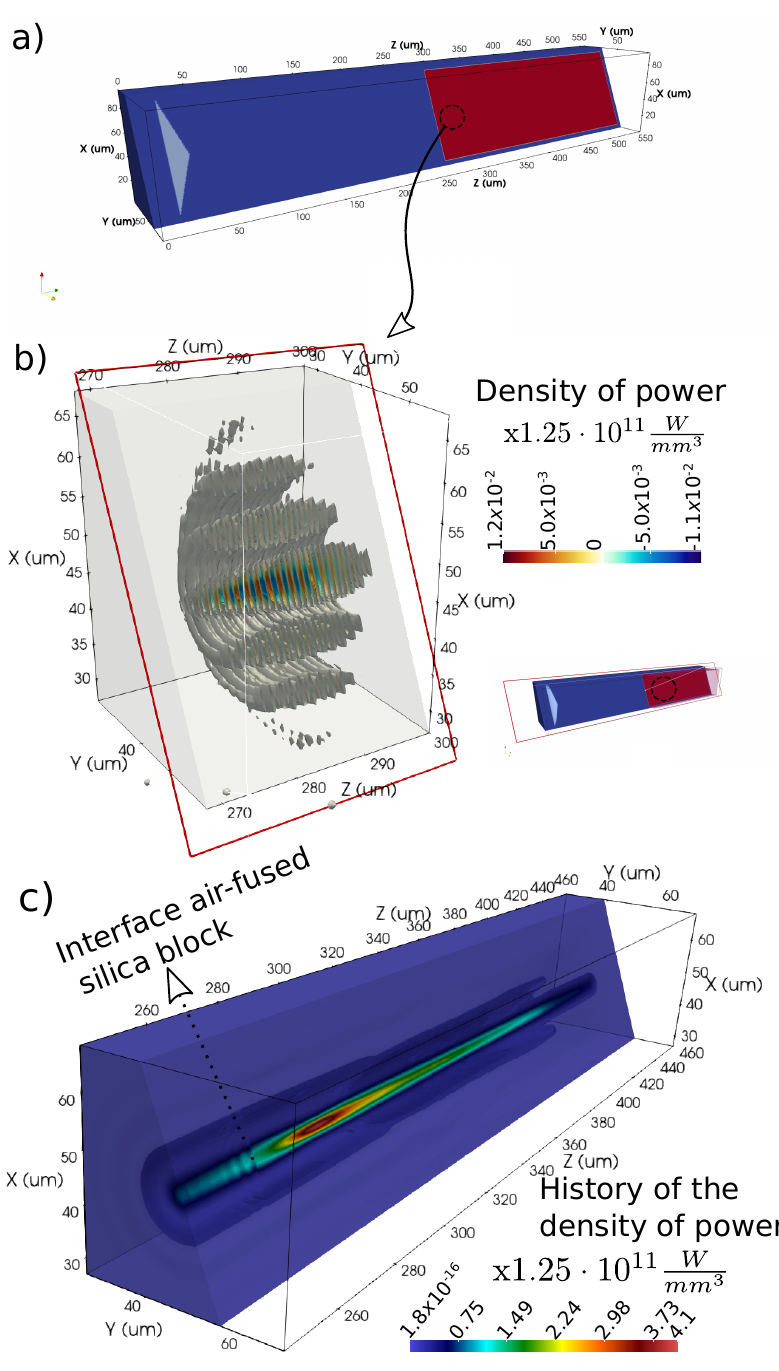
Figure 6. ( a ) Subsample taken from the computational domain in which we plot the pulsed density of power and the history of the power density. ( b ) Power density power plotted by means of iso-slices for a pulsed Bessel beam in power regime close to the critical value. the selected time corresponds to the Bessel beam entrance inside the fused silica block. We consider all nonlinear effects in this simulation. ( c ) History of the power density for a pulsed Bessel beam. At the interface between the fused silica bulk and the air a modulation is observed in the history of power